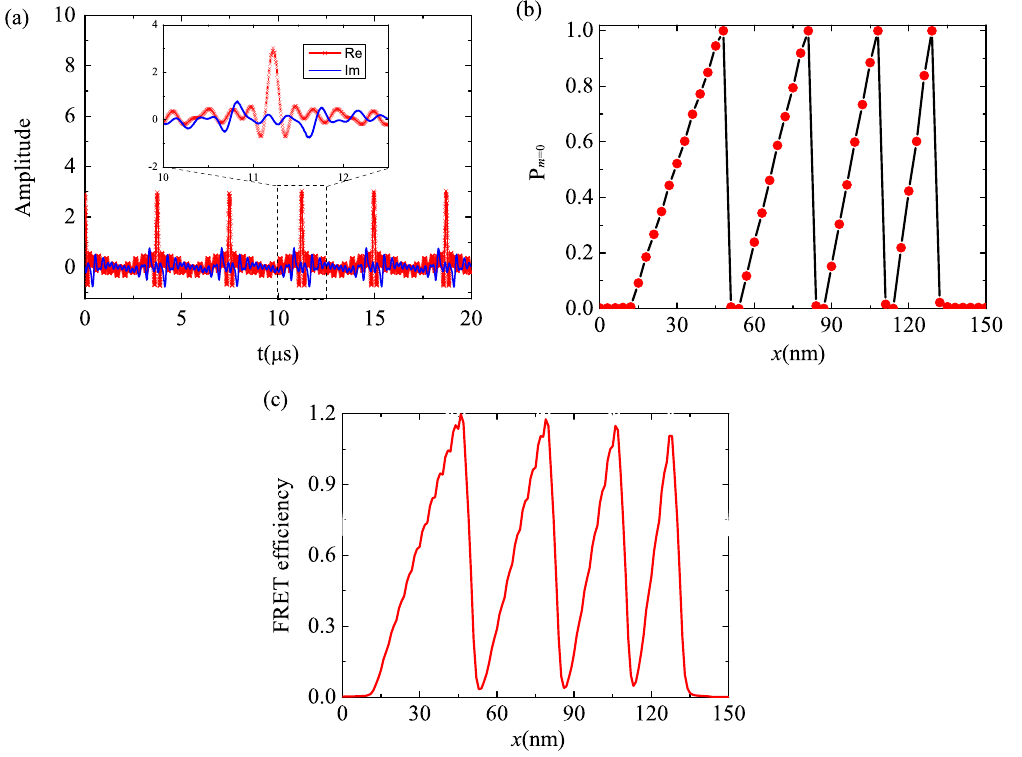
Figure 2. (Color online) ( a ) Complex RF pulse used to write a chirped grating. Red line with cross symbols is the real part while blue line without symbols is the imaginary part; ( b ) The spatial distribution of the probability that the spins are prepared in the bright state; ( c ) The Föster resonance energy transfer (FRET) efficiency on the substrate surface when the readout contrast is